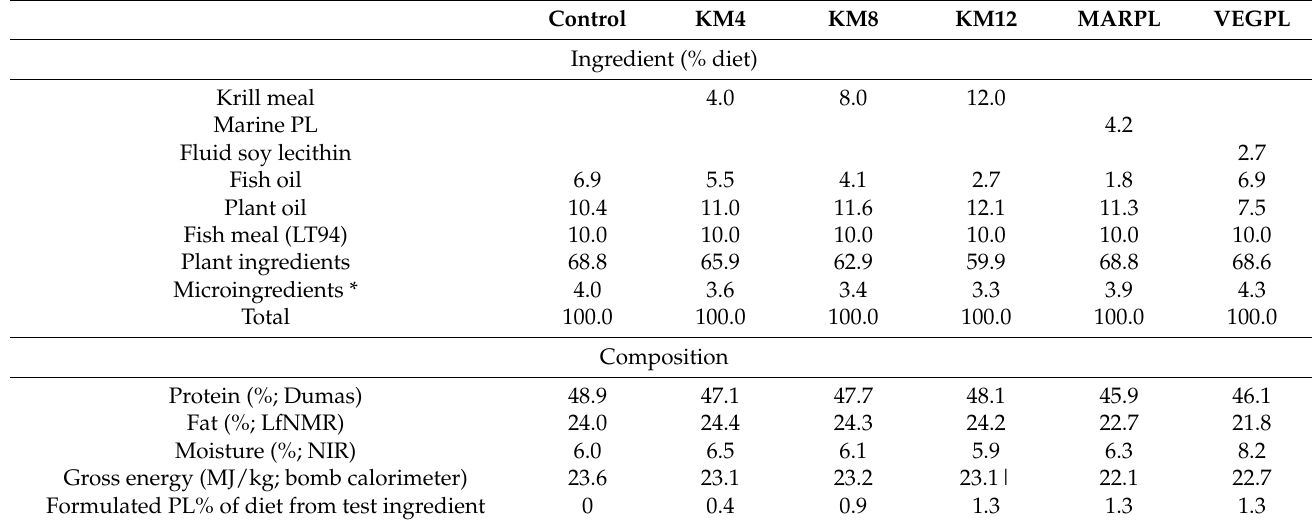
Table 1. Formulation and expected composition of test diets for the feeding trial in